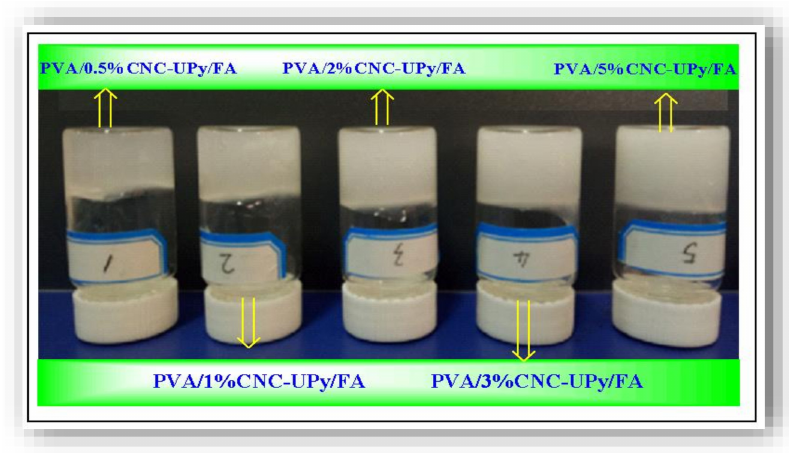
Figure 9. Photos of di ff erent PVA / CNC-UPy / FA composite